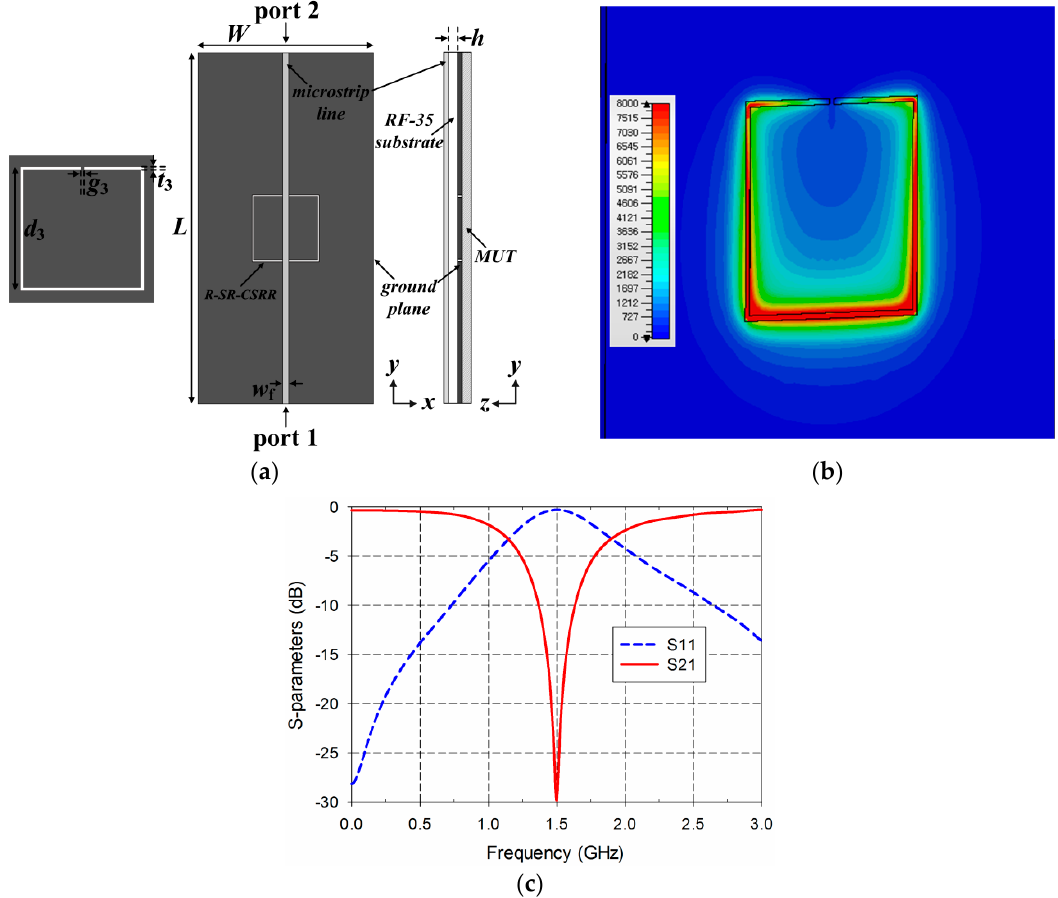
Figure 4. R-SR-CSRR-based permittivity sensor: ( a ) structure; ( b ) electric-field distribution at 1.5 GHz; ( c ) S-parameter characteristics.